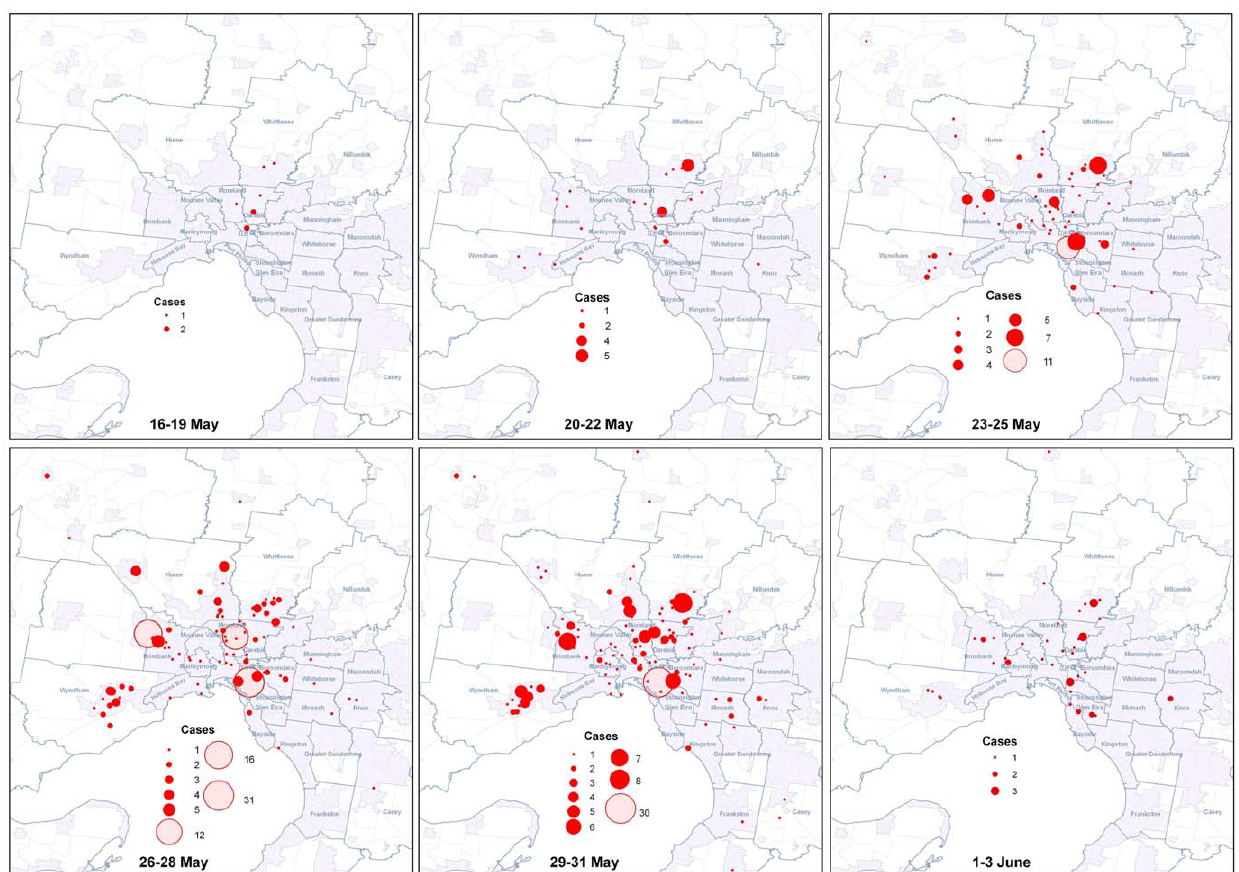
Figure 2. Confirmed influenza A(H1N1)pdm09 cases aged 5–17 years by school and date of onset, Victoria, 2009.